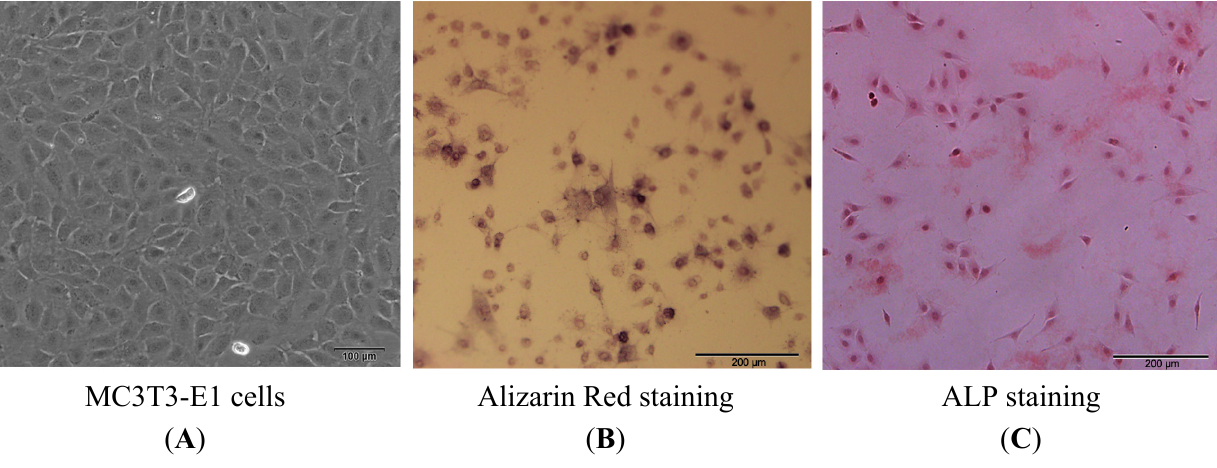
Figure 1. Growth and morphologic characteristics of MC3T3-E1 cells. ( A ) Cells grew in triangular and polygonal shapes; ( B ) Alizarin red staining for Ca deposits, extracellular matrix Ca deposits for matrix mineralization was measured using Alizarin red dye which bound with Ca; and ( C ) staining for alkaline phosphatase (ALP), cells were cultured in 6-well plates and incubated in AS-MX phosphate solution as substrate with Fast Red salt as stain, with matrix ALP activity shown as red